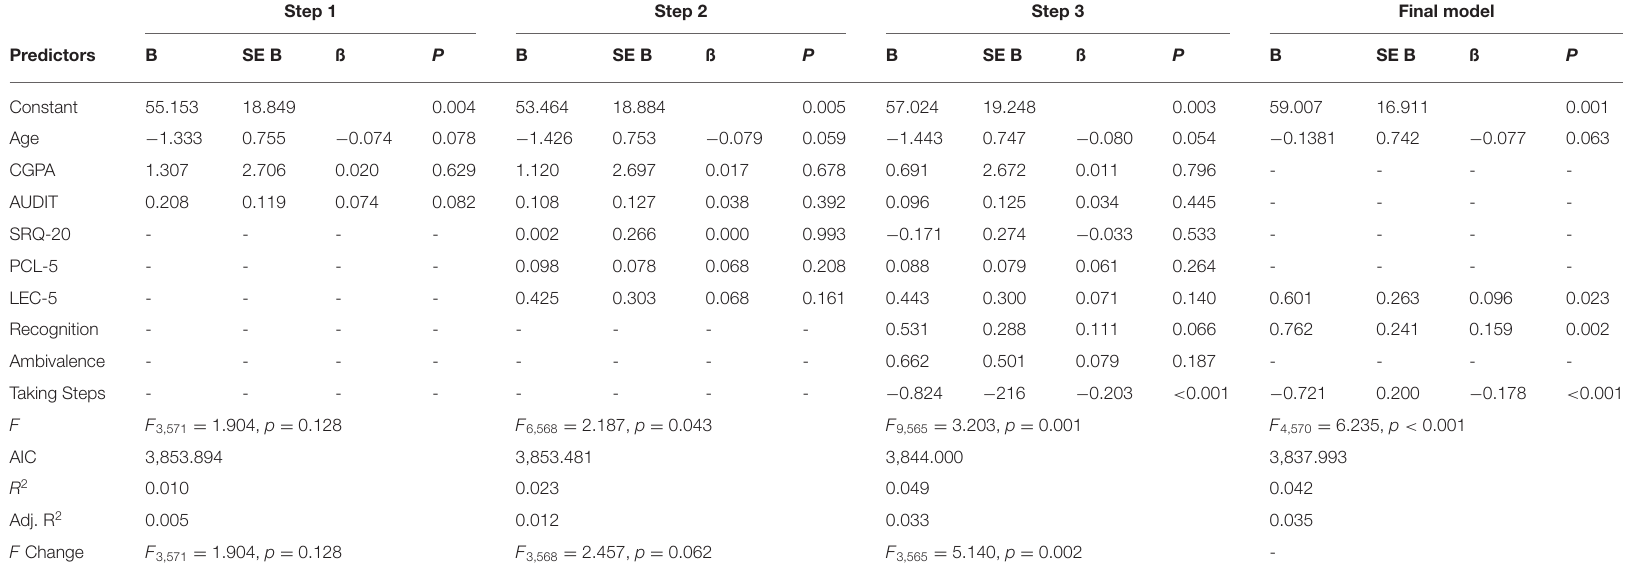
TABLE 3 | Summary of the linear regression model of dependent variable bundles of khat use in the last 28 days.